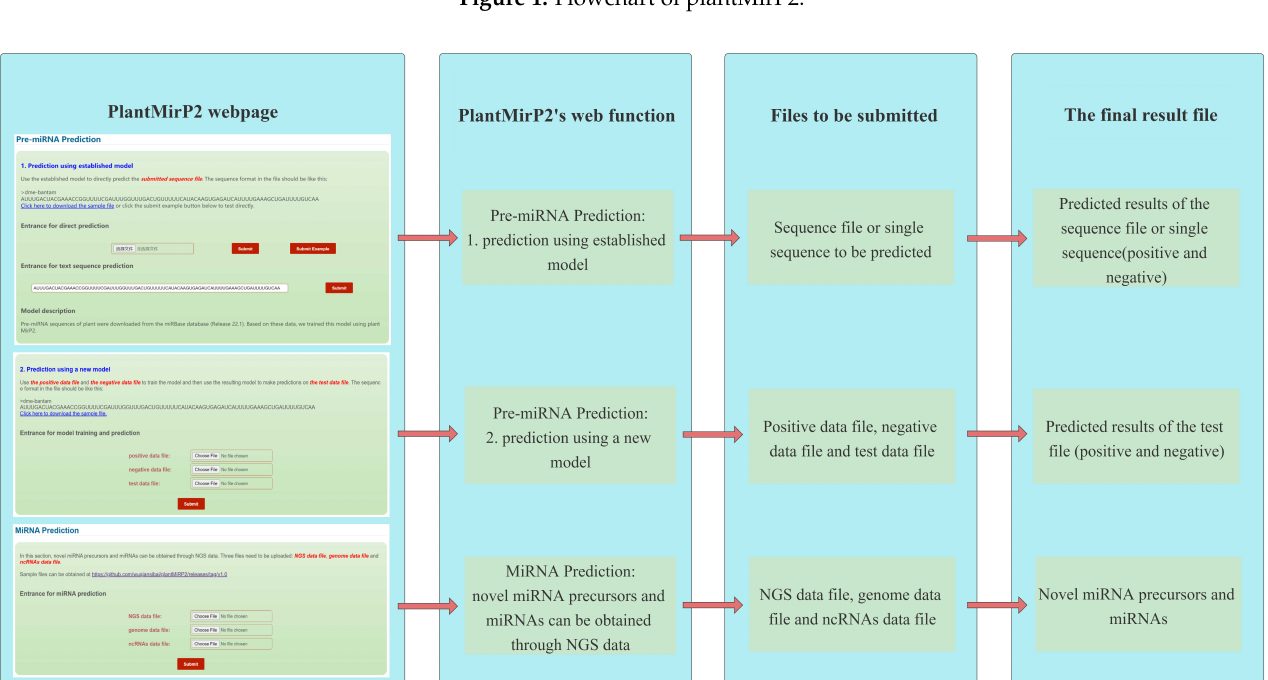
Figure 1. Flowchart of plantMirP2.